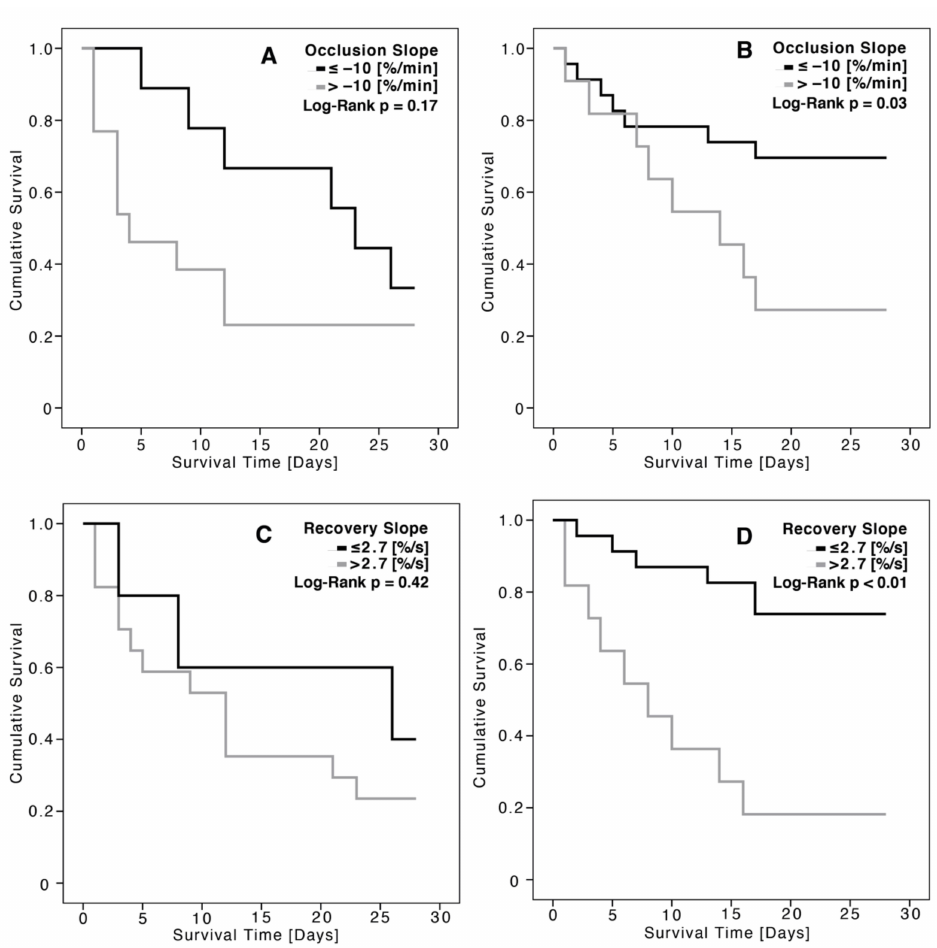
Figure 5. The VOT occlusion slopes at baseline regarding 28-day mortality for patients receiving RRT ( A ) and patients not needing RRT ( B ), as well as the VOT recovery slopes at baseline regarding 28-day mortality for patients receiving RRT ( C ) and patients not needing RRT ( D ), using Kaplan–Meier survival curves; level of significance measured by p